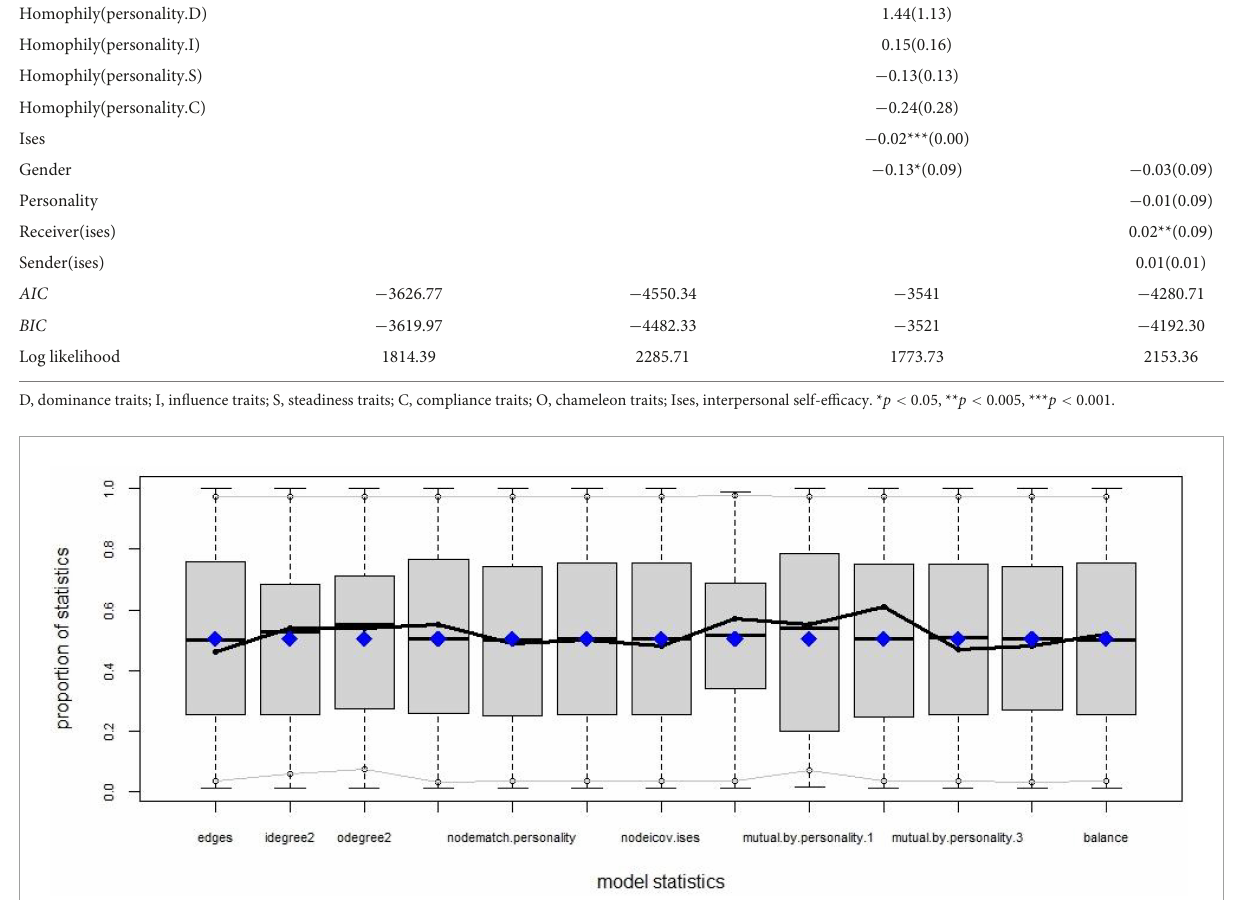
FIGURE5 Fitting effect of the exponential random graph